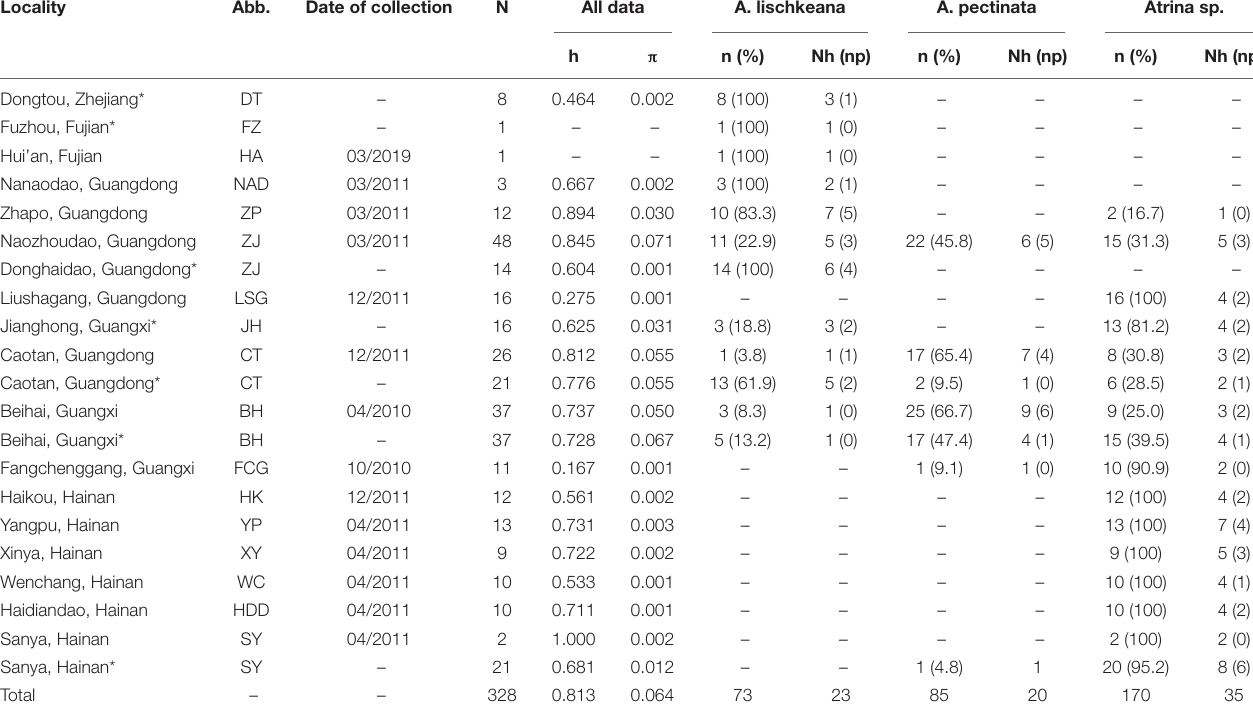
TABLE 1 | Sampling information and molecular diversity indices for mt COI